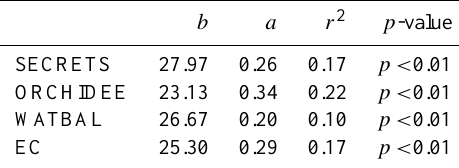
Table 3. Coefficients for the linear regression analyses between pre- cipitation (mmmonth − 1 ) and drainage (mmmonth − 1 ) for the four approaches (SECRETS, ORCHIDEE, WATBAL, eddy covariance [EC]). Included in the table are estimates of the coefficient of deter- mination ( r 2 ) and the p -values for each regression analysis.